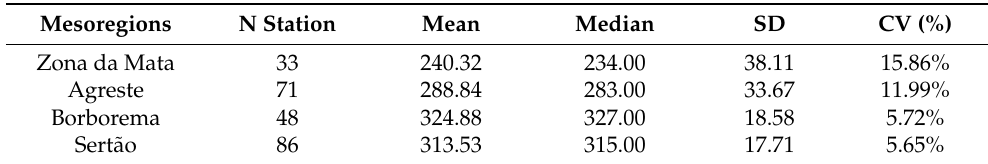
Table 1. Descriptive measures for the number of days without rain in the state of Para í ba from 1994 to